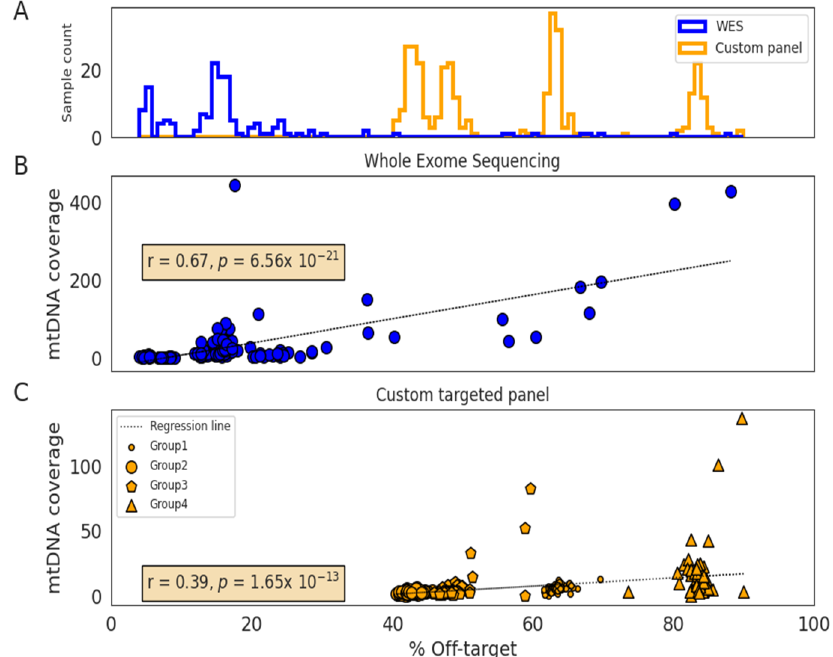
Figure 1. Distribution of o ff -targets according to the sequencing method and correlation with mitochondrial DNA coverage. ( A ) Histogram showing the o ff -target distribution of whole-exome sequencing (WES) ( n = 148; blue) and custom panel ( n = 325; orange) samples. ( B ) Correlation between o ff -target and mtDNA coverage in WES samples ( n = 148). ( C ) Correlation between o ff -target and mtDNA coverage in the custom-targeted gene panel samples ( n = 325). These samples were sequenced into four di ff erent library preparation next-generation sequencing (NGS) experiments (Group